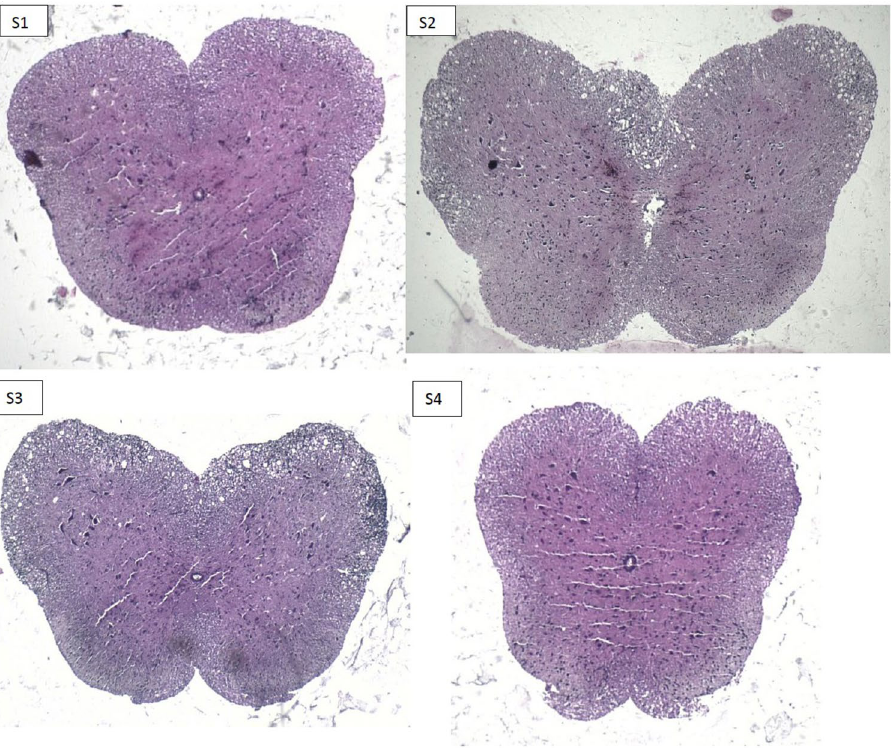
Figure 4. H&E stained pathological samples of Spinal cord End in: (S1) non-EAE group, (S2) EAE group, (S3) EAE-GA group, (S4) EAE-GA/Depot